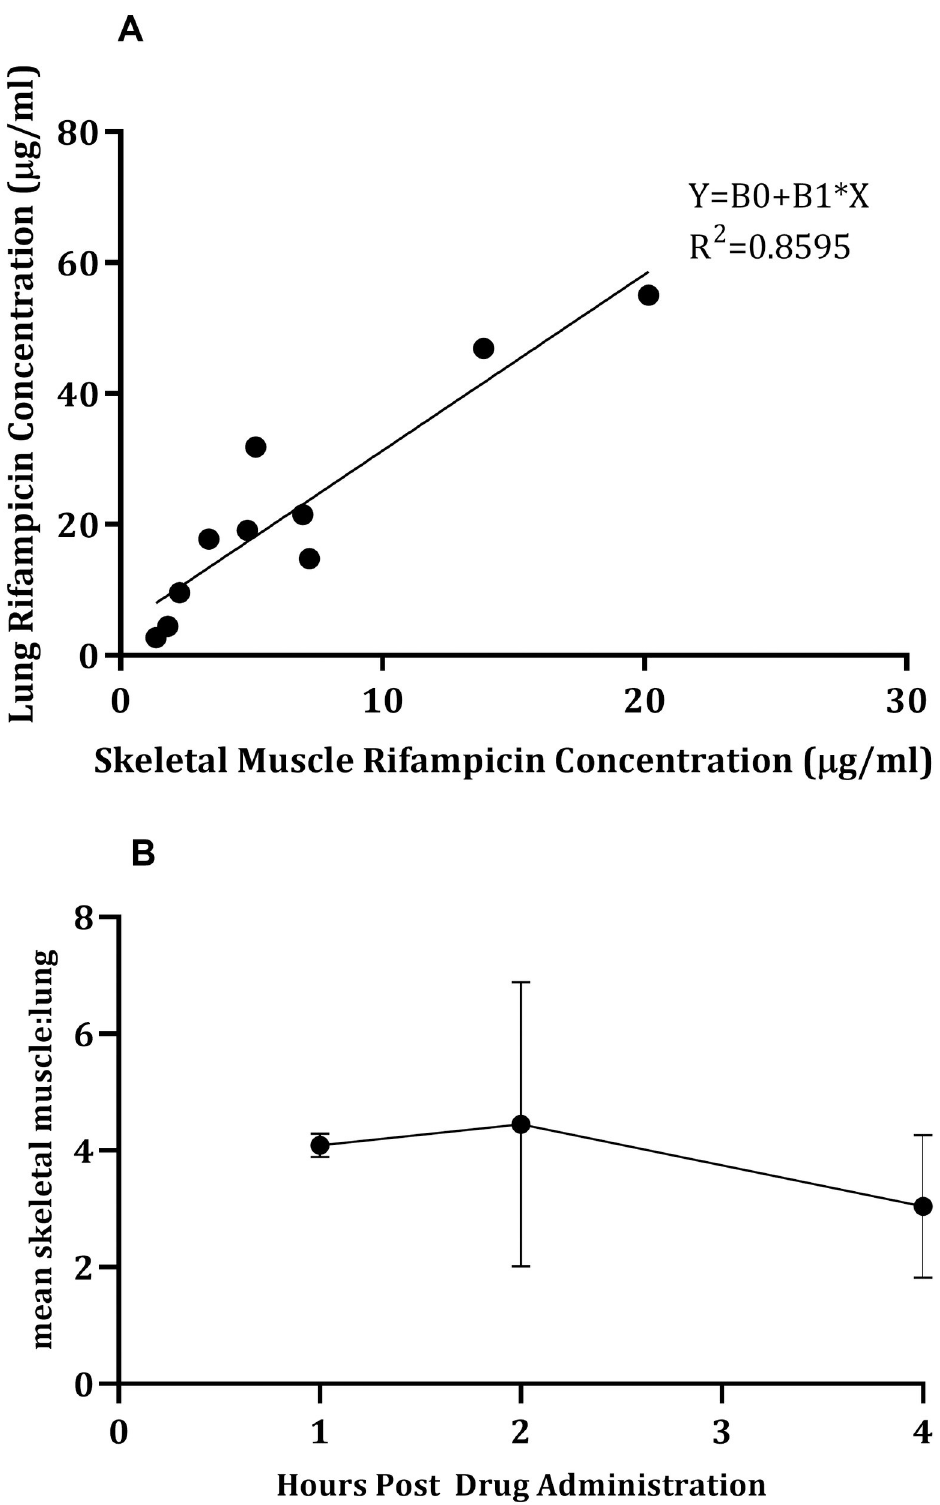
Fig 1. A : Correlation between rifampicin concentrations measured in lung and skeletal muscle. Data fitted with linear interpolation and the following equation generated; Y = B0+B1 � X, where B0 = 4.317, B1 = 2.695, X = unbound rifampicin concentration ( μ g/ml) recovered from sacrospinalis can be used to calculate Y, the estimated unbound